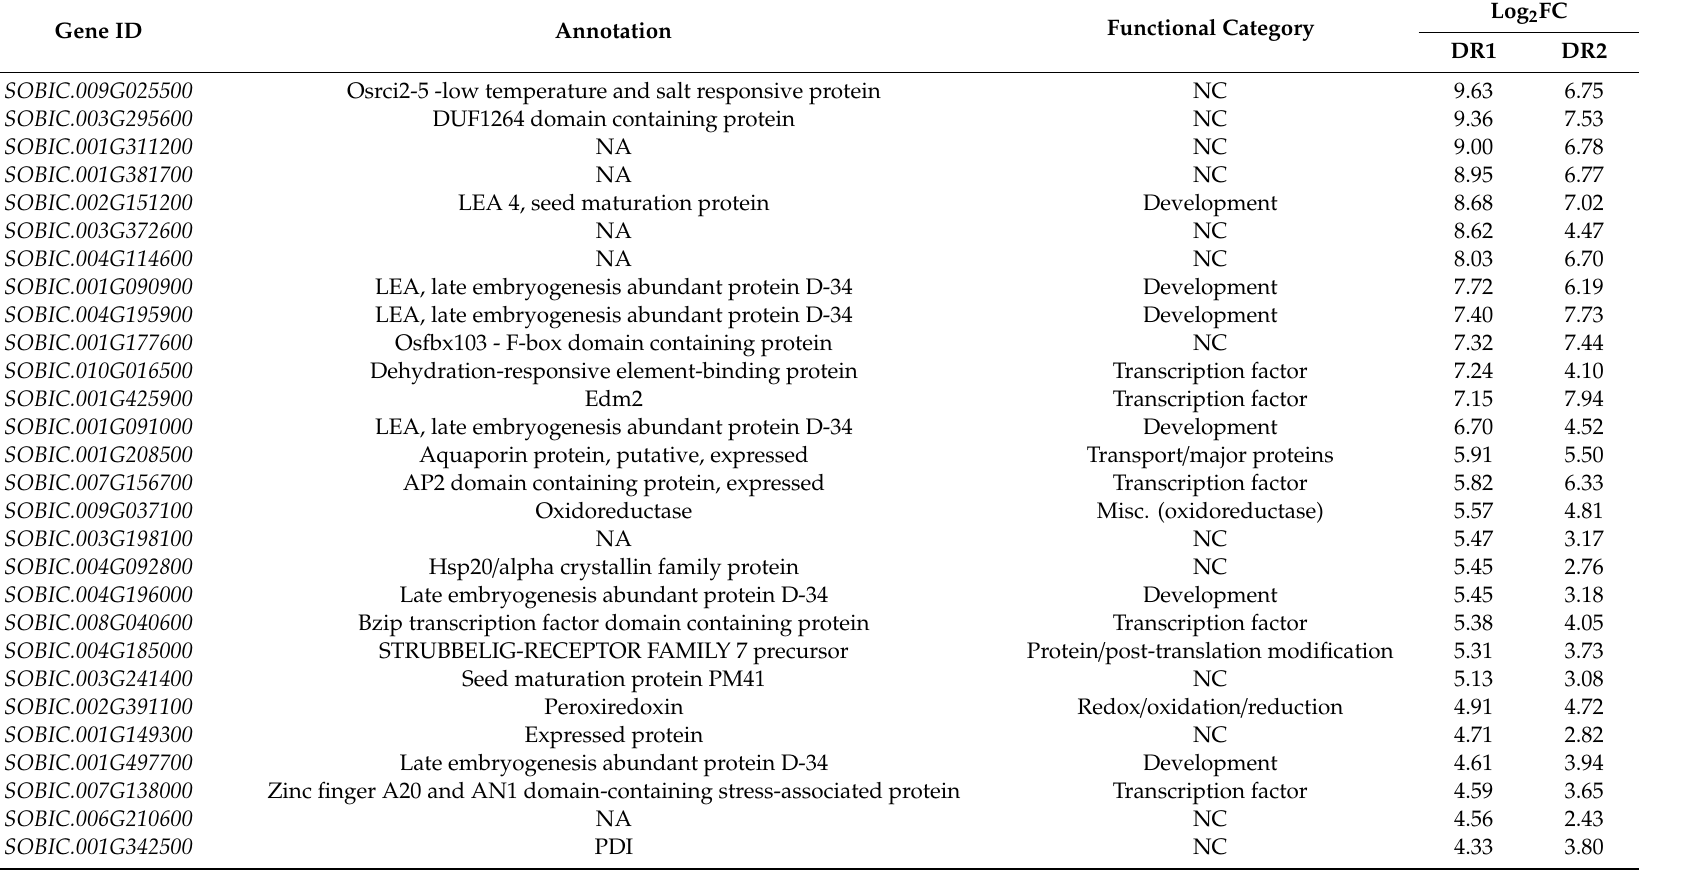
Table 3. Genes ID, annotation, functional category and Log 2 FC of DEG in drought-resistant genotypes treated with PEG for 6 h. NA means not annotated, NC means not categorized. The functional category was extracted from MapMan analysis using the list of DE genes that show Log 2 FC ≥ 2 or ≤ 2 and q -value < 0.05. Down-regulated genes are indicated in